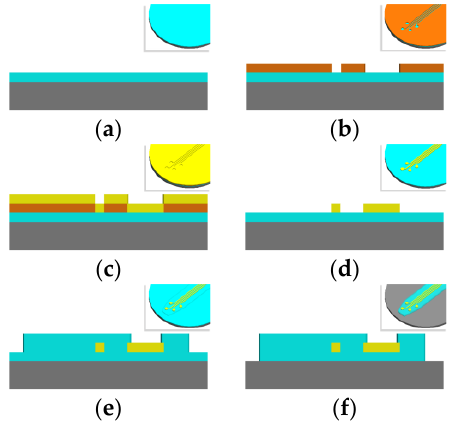
Figure 3. Fabrication process template in cross-section and isometric views (inset) in the following processing steps: ( a ) substrate polymer deposition; ( b ) sacrificial layer deposition and photolithography; ( c ) metal deposition; ( d ) sacrificial layer removal; ( e ) insulation polymer deposition and etching; and ( f ) outline etching and